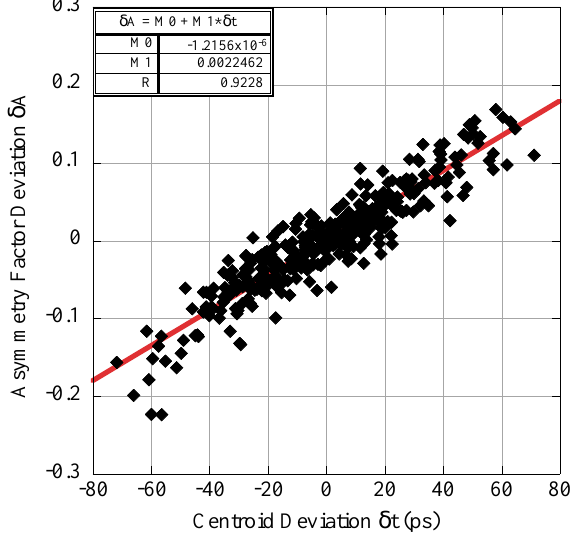
FIG. 29. (Color) The change in the asymmetry factor as a func- tion of centroid deviation when the trains are